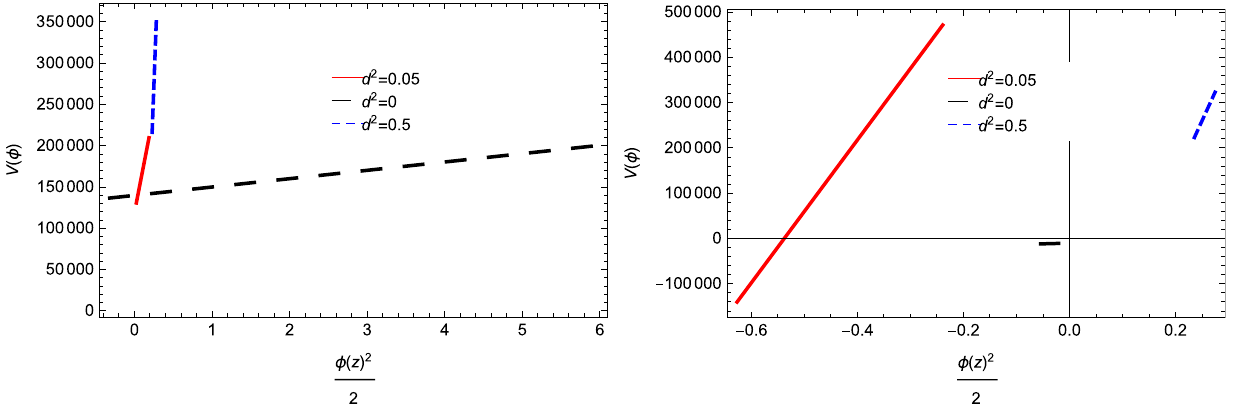
Fig. 42 Plot of φ verses V for u = 1 and u = 2 . 002 for K-essence scalar field